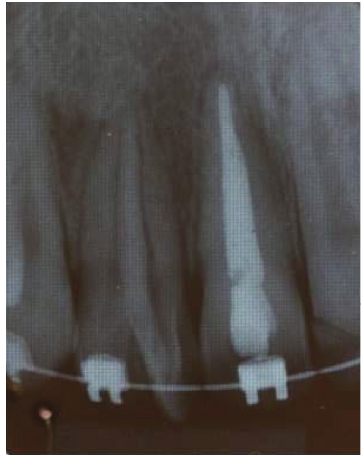
Figure 2: Periapical radiograph of the right maxillary lateral incisor and the supernumerary tooth with increased radiopacity in both roots suggesting overlapping